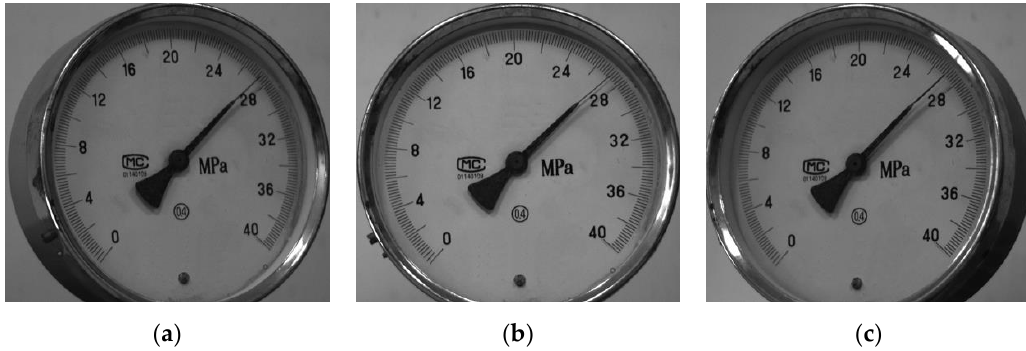
Figure 5. Measured pointer meter captured from three di ff erent angles; ( a ) the camera at position 1; ( b ) the camera at position 2; ( c ) the camera at position 3. r and First, the radius l